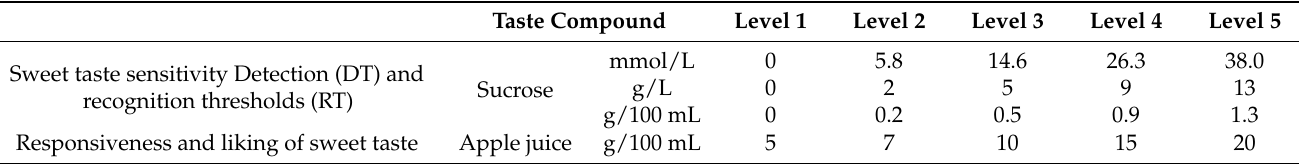
Table 1. Sweet taste sensitivity and responsiveness and liking of sweet